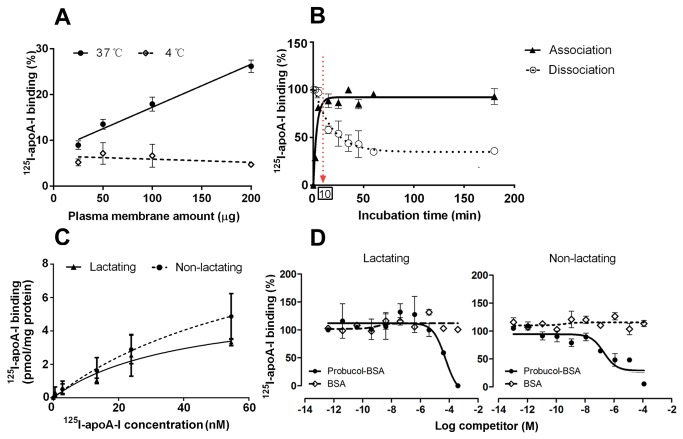
Binding of 125I-apoA-I to mammary gland (MG) enriched plasma membrane vesicles (EPM).A: Representative graph of 125I-apoA-I binding (5nM) to increasing concentrations of EPM (range 0.25 to 2 mg/ml) at 37°C (●) and 4°C (□). Dose-dependent 125I-apoA-I binding was only observed at 37°C. B: Representative curves of 125I-apoA-I binding (10nM) kinetics at 37°C to a fixed amount (100µg) of EPM. For the association binding of 125I-apo-A1 (▲), the maximal binding (saturation) was reached after 10 min incubation at 37°C, and was expressed as 100% binding. For the dissociation binding (○), 125I-apoA-I binding was incubated for 15 min at 37°C. Then, excess amounts (40µg/ml) of cold apoA-I were added and the dissociation of 125I-apoA-I was evaluated at indicated incubation times. Data shown are from lactating MG. Similar curves were obtained for non-lactating MG. C: Saturation binding curve of 125I-apoA-I (range 2 to 56nM) to a fixed amount (100µg) of EPM from lactating (▲) and non-lactating (●) MG tissues. The reaction was incubated for 15 min at 37°C. D: Competition binding of 125I-apoA-I to a fixed amount of EPM (100µg) from lactating and non-lactating MG tissues by probucol-BSA (●) and BSA (◊). The probucol-BSA complex was prepared as described by others (37). The reaction was incubated for 15 min at 37°C. All other details of the binding procedure were as described in Figure 2 except that the radioactivity of the filters was measured with a γ-counter. All data are expressed as means ± SD.